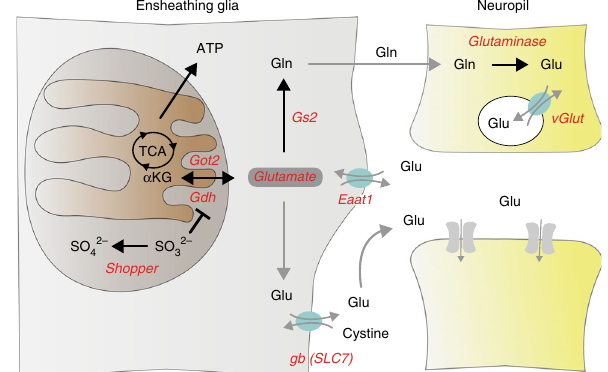
Fig. 8 Shopper in fl uences the glutamate metabolism in the nervous system. Schematic view of glutamate homeostasis in glial cells and its contribution to the glutamate – glutamine cycle. Glutamate (Glu) can be generated from α -ketoglutarate ( α KG) by glutamate dehydrogenase (Gdh) or from aspartate and α -ketoglutarate (glutamate oxaloacetate transaminase, Got2). Glutamate is then converted to glutamine by glutamine synthetase 2 (Gs2) or is exported by SLC7 type transporters which in Drosophila is Genderblind (gb). In addition, glutamate can be taken up from the extracellular space by the excitatory amino acid transporter 1